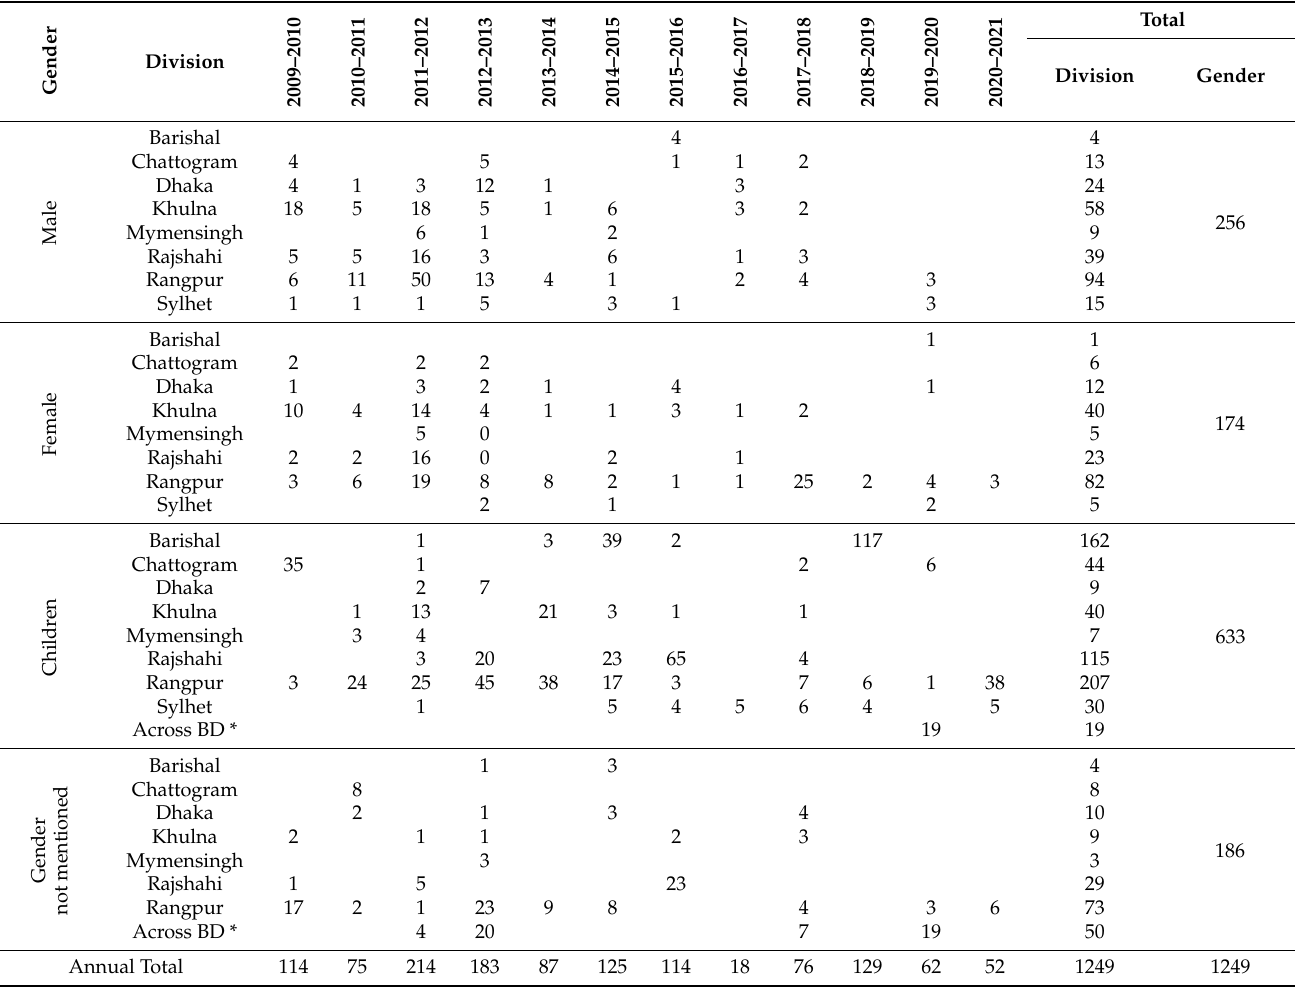
Table A1. Gender distribution of cold-related deaths in the divisions of Bangladesh during the winter months of 2009–2021.